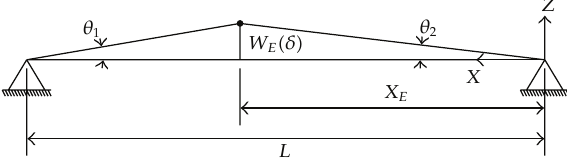
Figure 23: Parabolic interaction criterion.